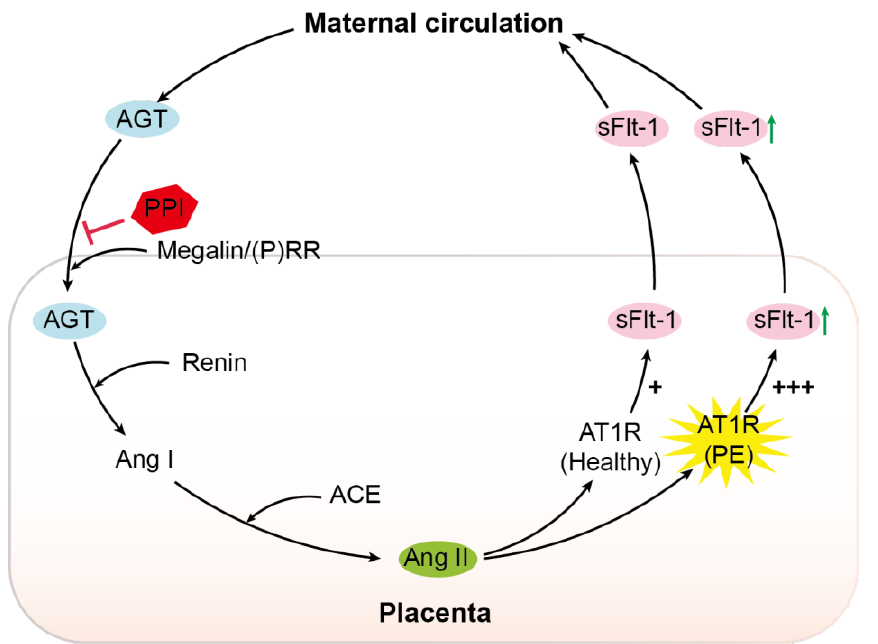
Figure 6. Schematic overview. AGT, angiotensinogen; , inhibition; PPI, proton pump inhibi- tor; (P)RR, (pro)renin receptor; Ang I, angiotensin I; ACE, angiotensin-converting enzyme; Ang II, angiotensin II; AT1R, angiotensin II type 1 receptor; PE, pre-eclampsia; sFlt-1, soluble Fms-like tyrosine kinase-1; +, normal sensitivity to Ang II; +++, increased sensitivity to Ang II.